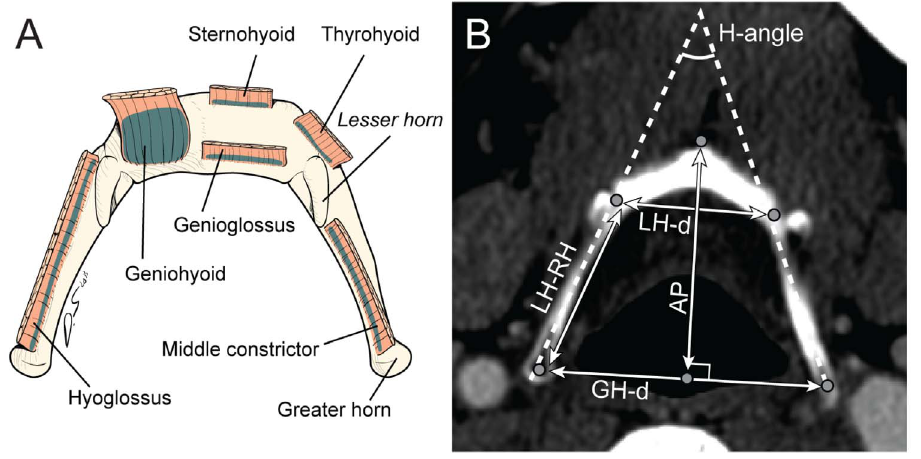
Figure 1. Anatomy of hyoid bone and new parameters. A . Schematic of the hyoid bone and attachment sites with the upper airway pharyngeal muscles. B . Axial image of the hyoid bone on a computed tomographic (CT) scan. Parameters that were measured are indicated on the CT image and include the following: LH-d , distance between the bilateral lesser horns; GH-d , distance between bilateral greater horns; AP , distance from the most anterior end of hyoid arch to GH-d; H-angle , angle made by bilateral extension lines between greater and lesser horn; GH-LH , distance between greater and lesser horns.